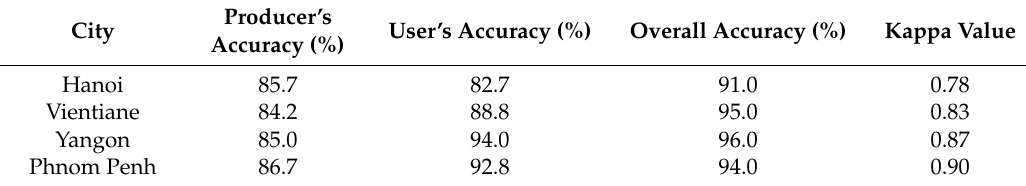
City Producer’s Accuracy (%) User’s Accuracy (%)